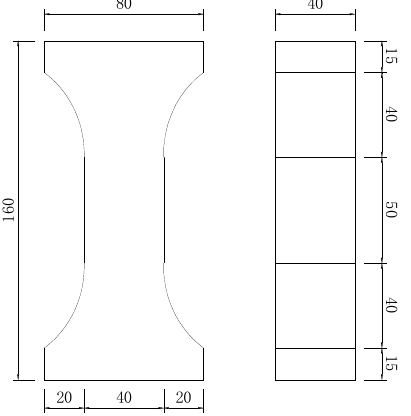
Figure 1. The specific dimension of dog bone specimen (dimension in mm).